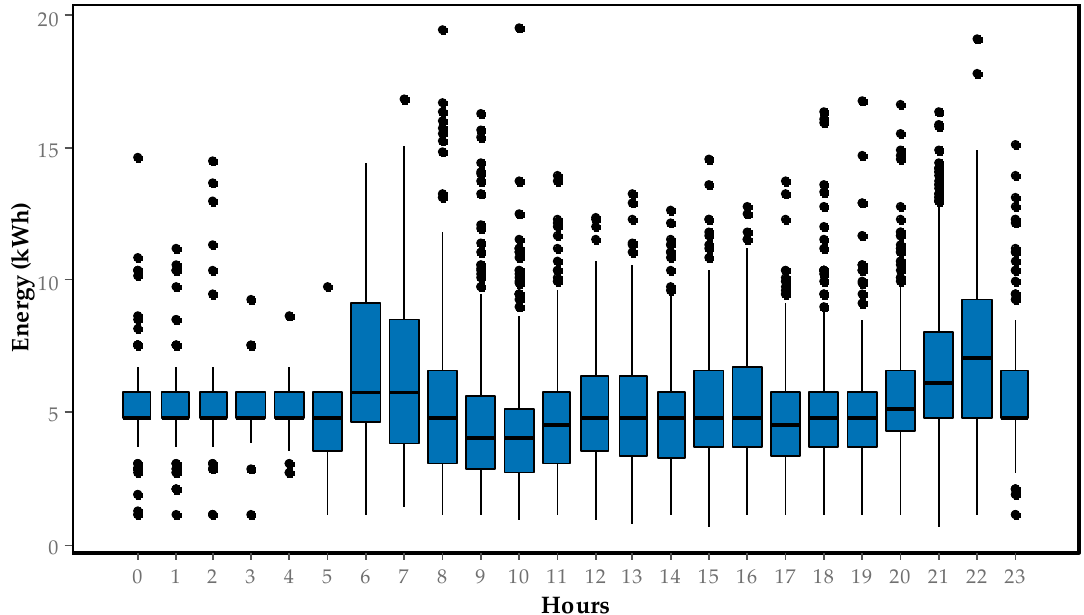
Figure 2. Boxplot of the amount of energy of charges within each hour of the day.